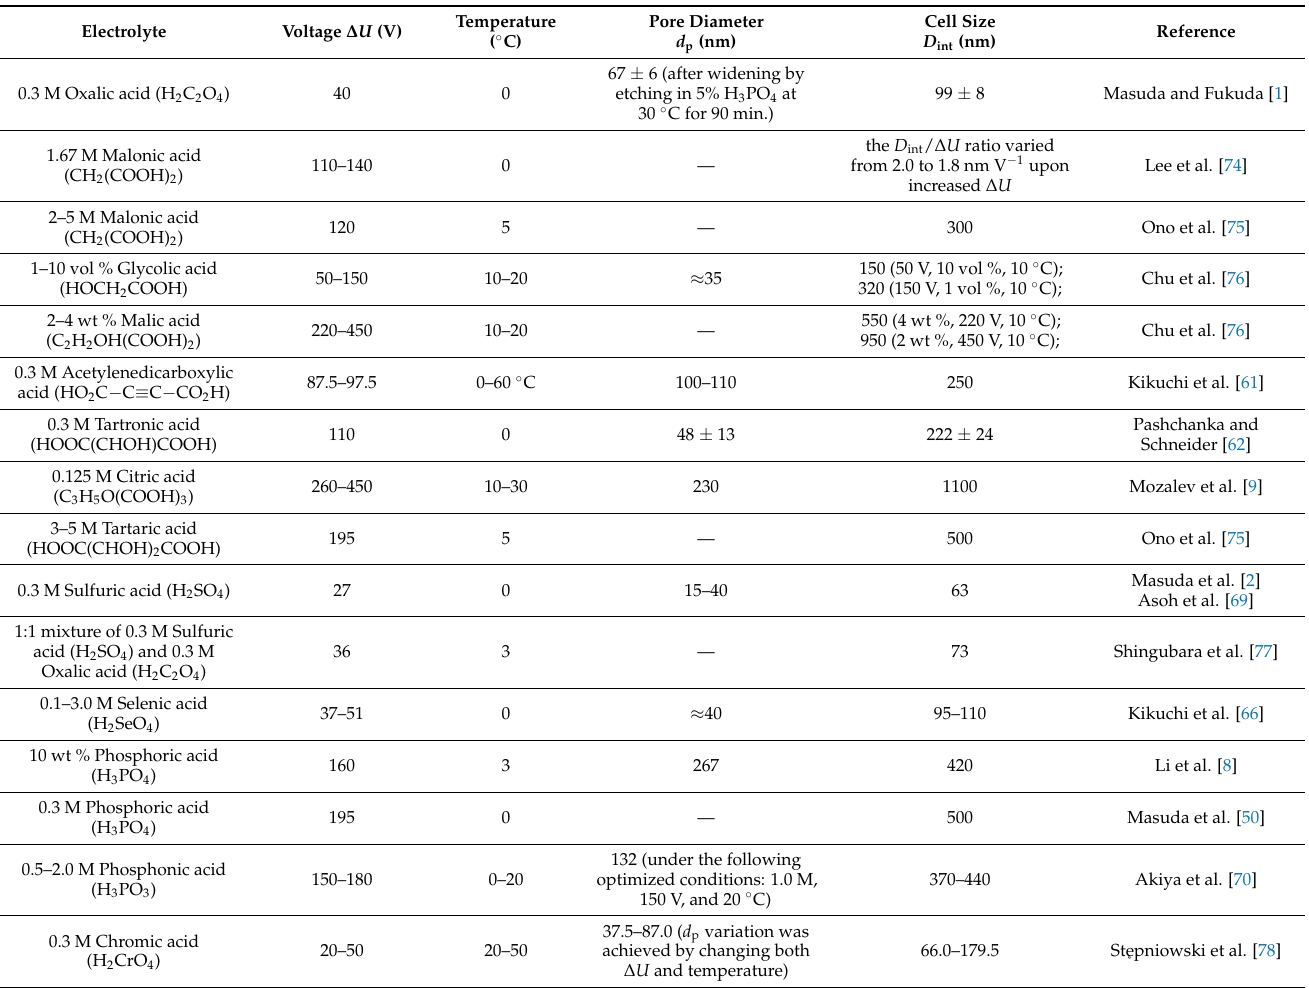
Table 1. Suitable electrolyte compositions, corresponding anodizing regimes, and resulting PAA pore diameters d p and cell sizes (or interpore distances D int ) from selected